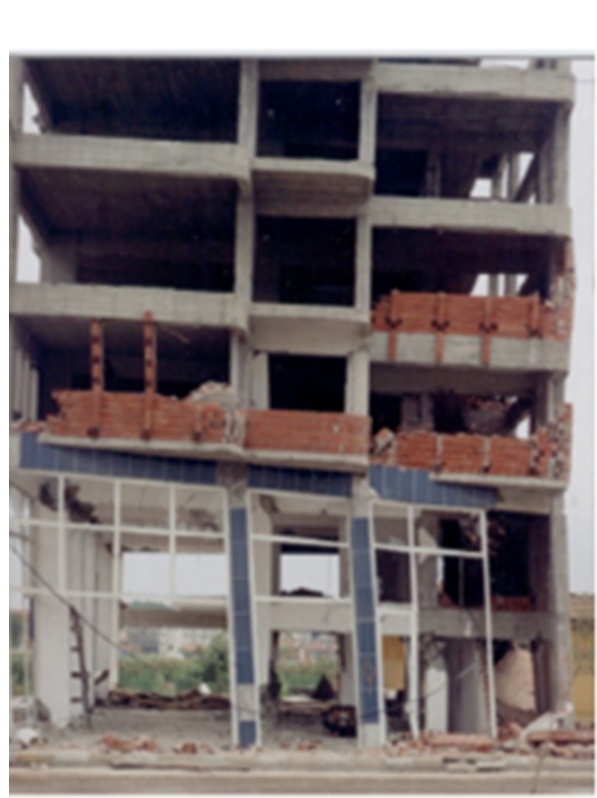
Figure 9. Heavy damage in the weak story of a five-floor building in Adapazari (17 August 1999 Kocaeli earthquake, M = 7.4) (Isik G.,